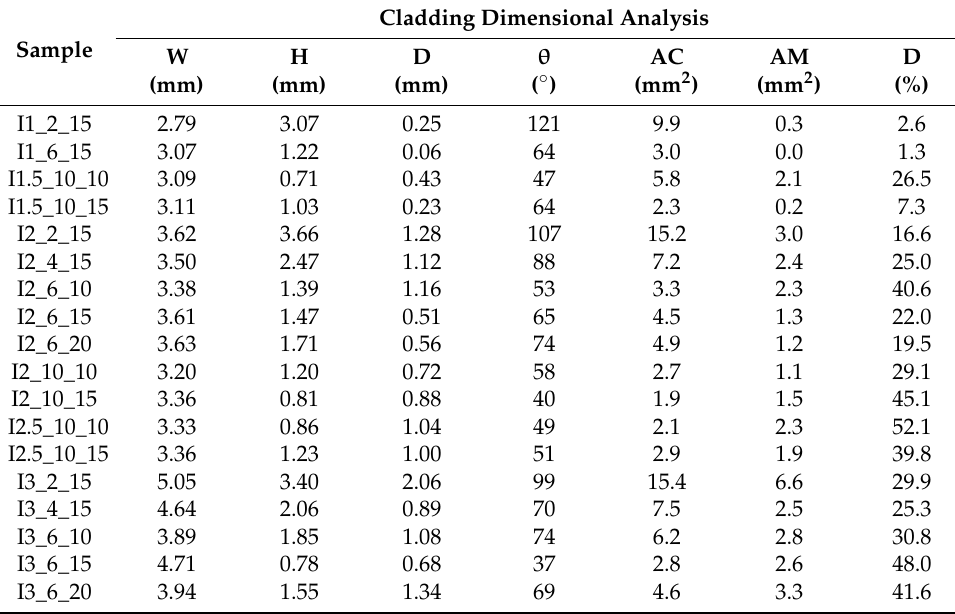
Table 3. Dimensional analysis of claddings produced by DLD.